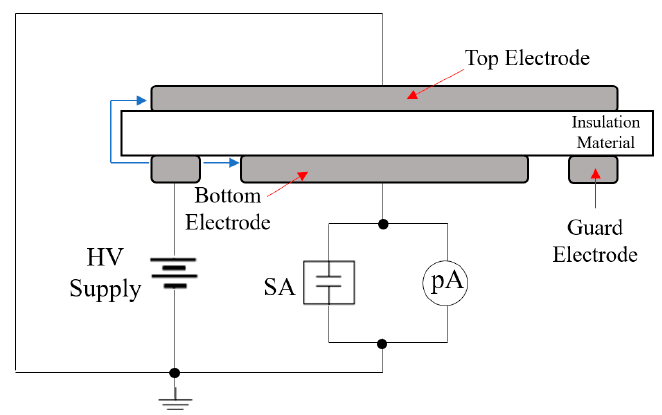
Figure 4. Circuit diagram for measuring the surface resistivity.